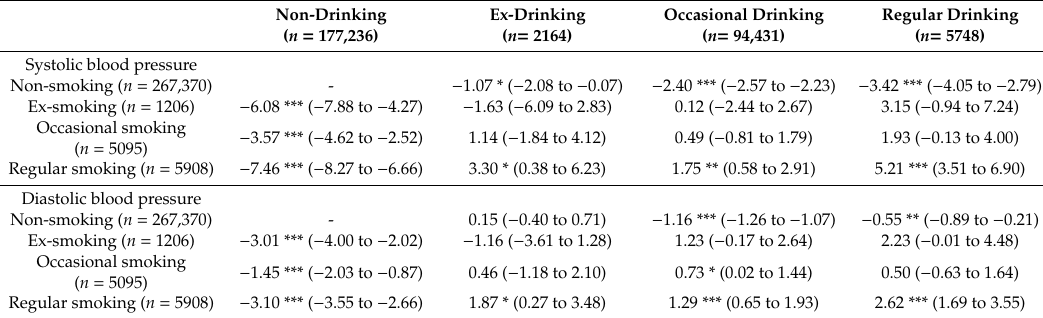
Table 5. Multivariable a linear regression coe ffi cients (95% confidence interval) for systolic and diastolic blood pressure levels according to smoking and alcohol consumption status in women.